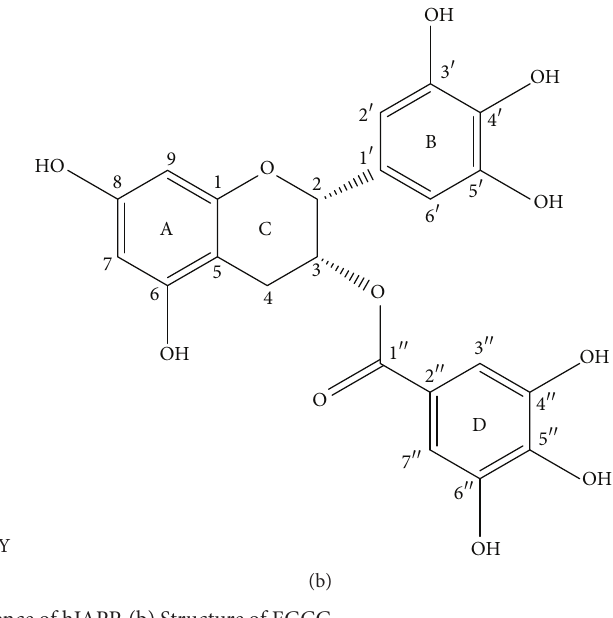
Figure 1: (a) Sequence of hIAPP. (b) Structure of